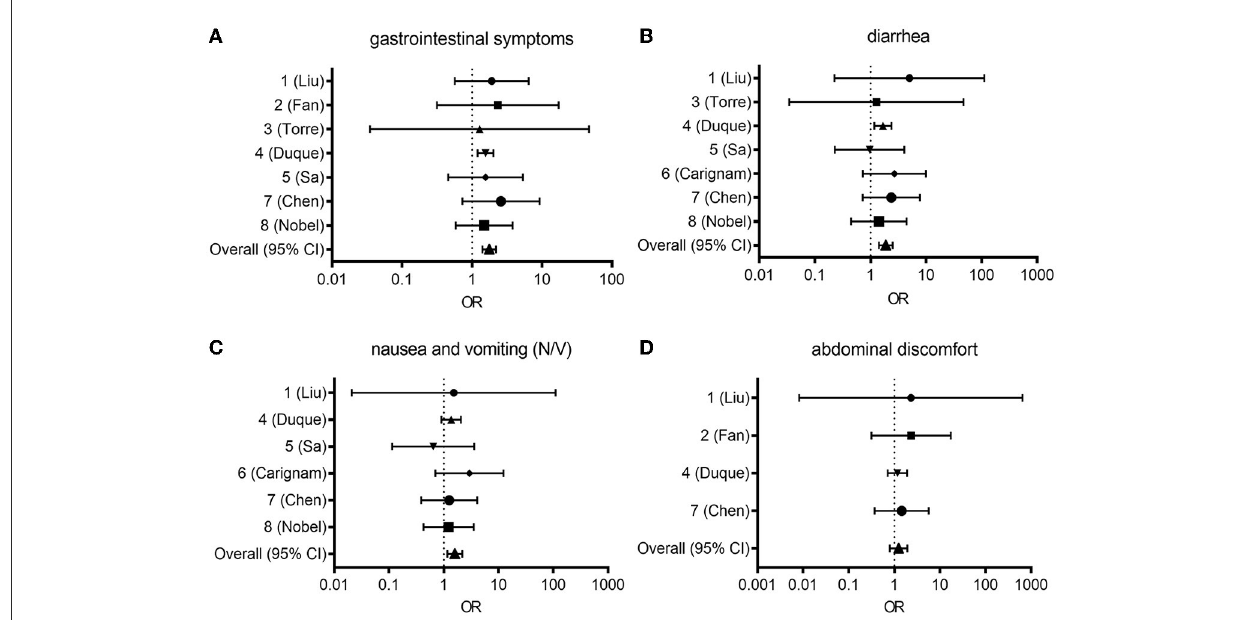
FIGURE1 Forest plot from random effects analysis: OR for presenting any gastrointestinal symptom (A) , diarrhea (B) , nausea and vomiting [N/V, (C) ], abdominal discomfort (D) in the COVID-19 group vs. the control group. CI, confidence interval; COVID-19, coronavirus disease 2019; OR, odds